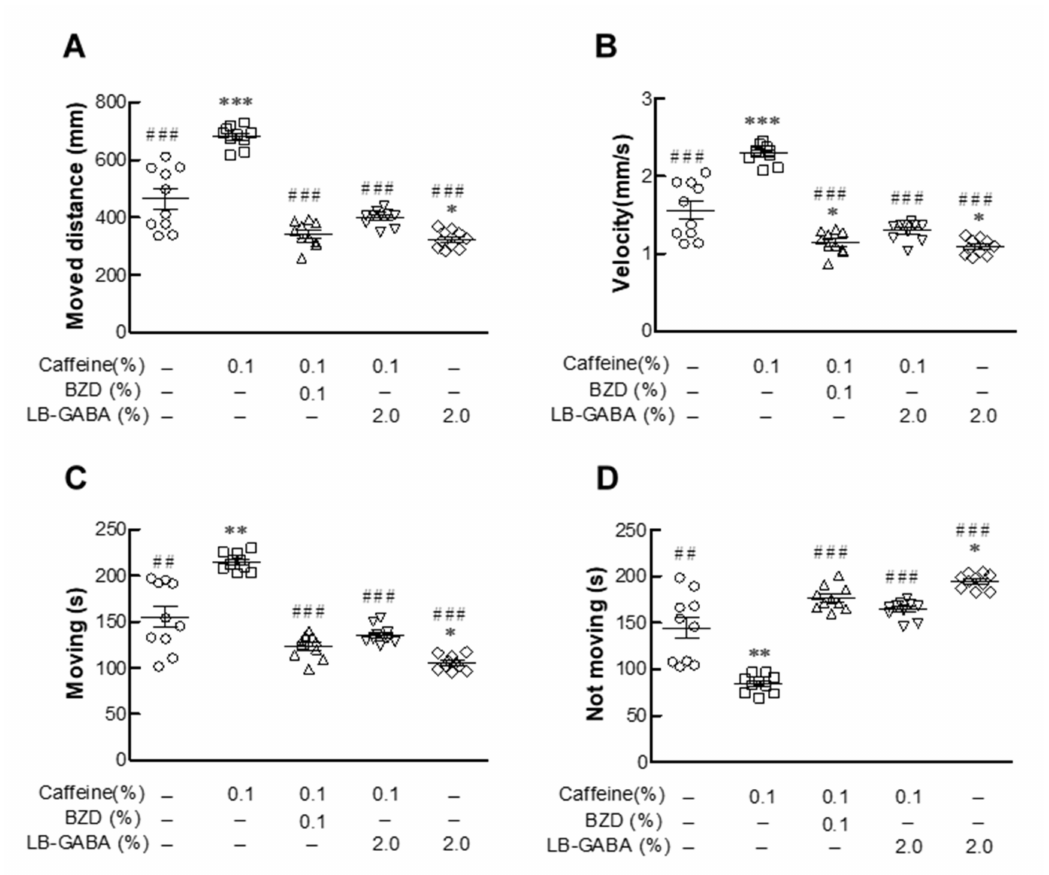
Figure 4. Effects of Lactobacillus -fermented γ -aminobutyric acid (LB-GABA) on movement of fruit files. Movement of flies was determined using a white board every 5 min for 1 h before subjective nighttime. ( A ) Moving distance (mm), ( B ) velocity (mm/s), ( C ) movement time of flies from center point, and ( D ) immobility time of flies from center point of control (sucrose–agar medium), 0.1% alprazolam (benzodiazepine BZD)-treated, and LB-GABA-treated (2.0%) groups compared with 0.1% caffeine-treated group using Noldus EthoVision-XT system. Values are means ± standard deviation (SD); * p < 0.05, ** p < 0.01, and *** p < 0.001 versus normal group(no treatment); ## p < 0.01 and ### p < 0.001 versus caffeine-only group according to Tukey’s multiple comparison test.